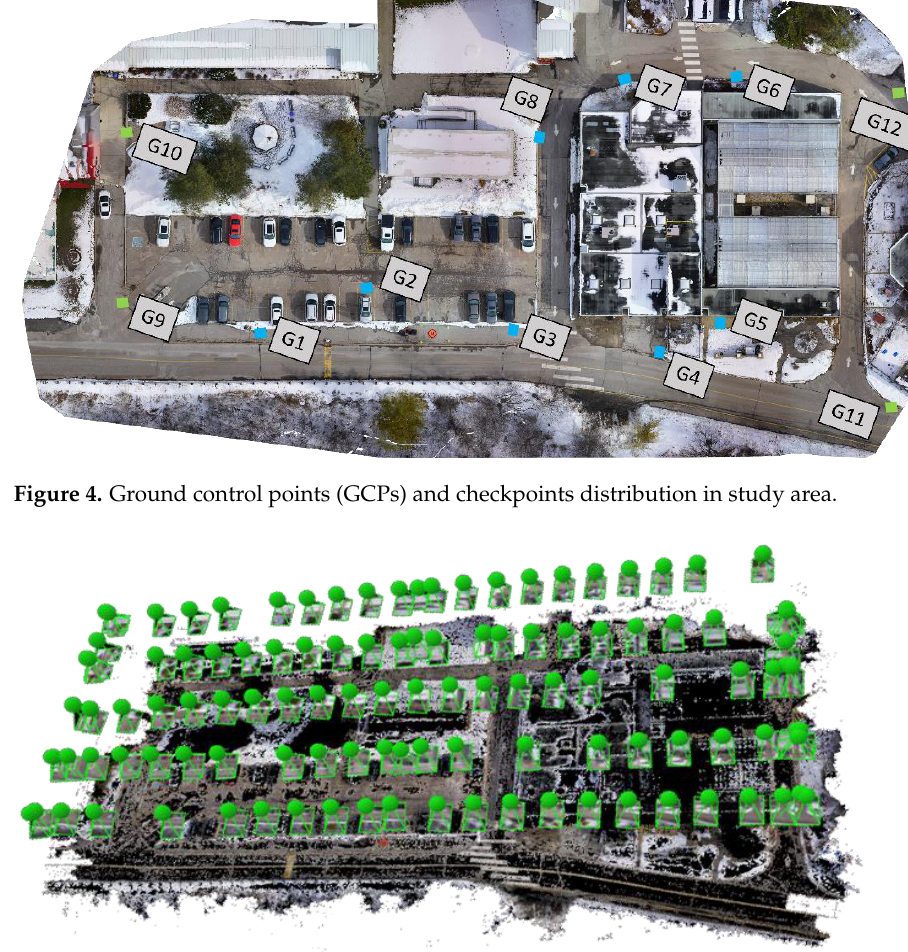
Figure 5. Camera poses estimated using Pix4D mapper software. Table 1. Absolute camera position (m) and orientation (deg) error statistics.